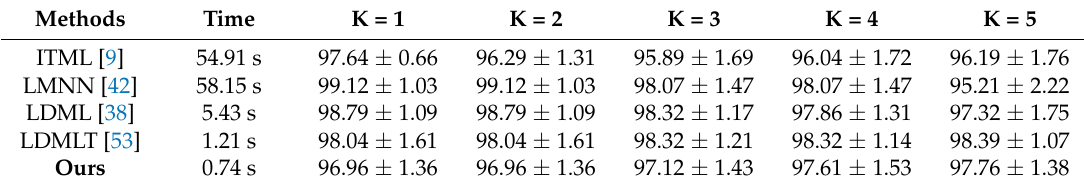
Table 5. The average of recognition rate (%) and training time for different metric learning methods in the AMI